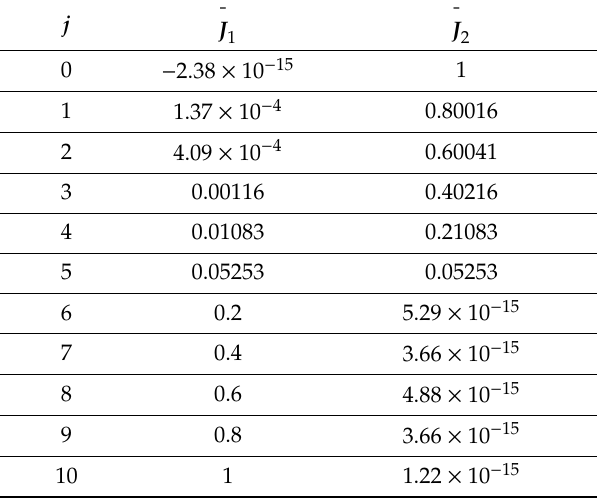
Table 1. Total system operation costs and total carbon emission costs represented by 11 Pareto frontier